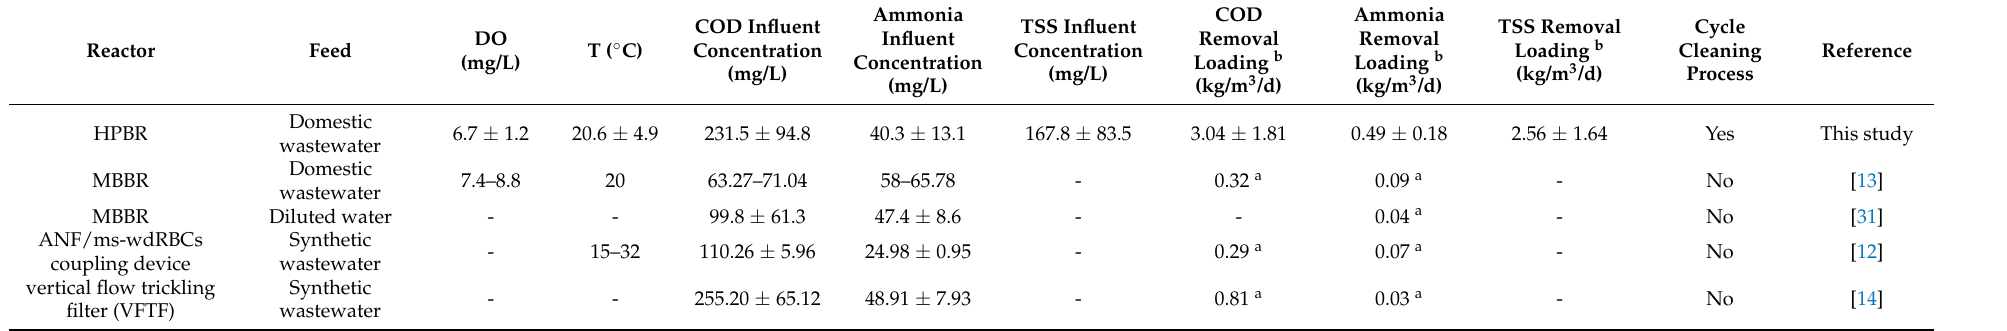
Table 3. Comparison of nutrients removal loading with other